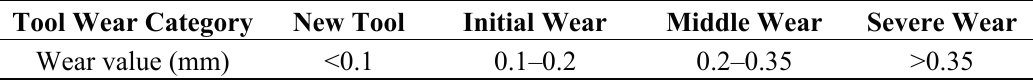
Table 2. Tool wear categories and its corresponding wear